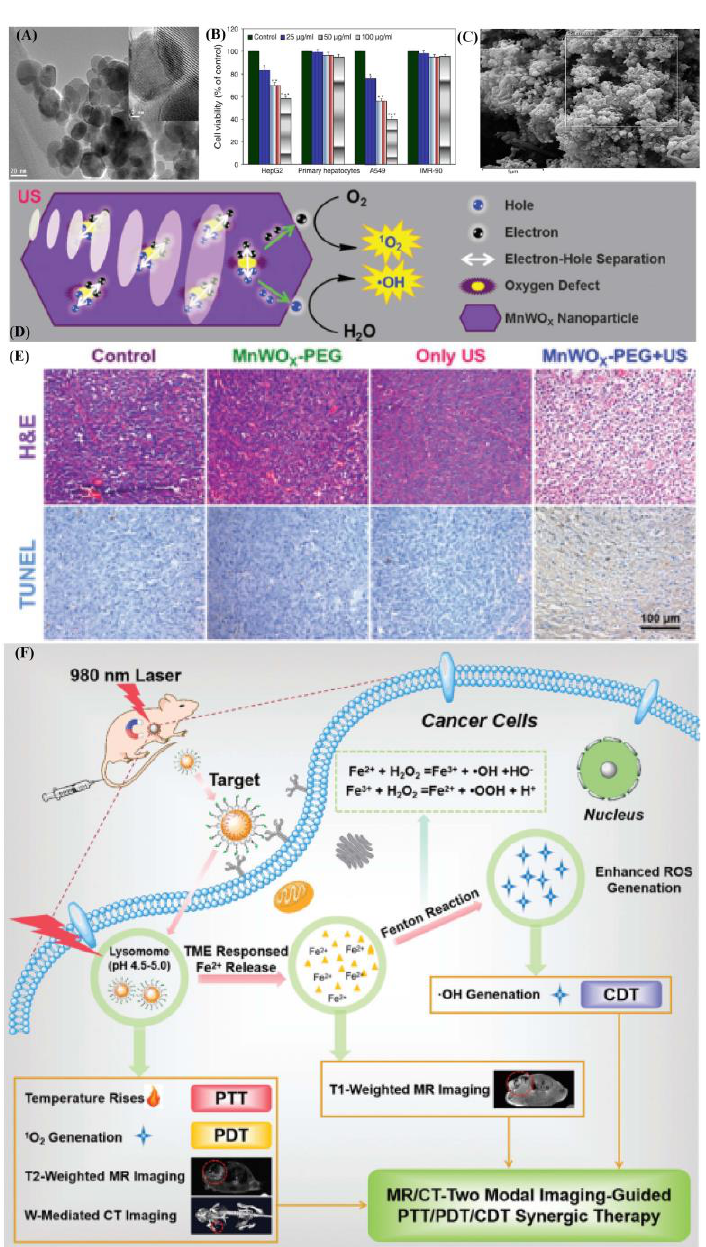
Figure 4. Metal-based magnetic composites as functional hard template in fabricating typical materials. ( A , B ) Structural information of pure phased Fe 3 O 4 and biocompatibility were tested in normal and cancer cell lines. Effect of Fe 3 O 4 on the viability of cancer cells and two types of normal cells; ( C ) FE-SEM image structural information of Fe 3 O 4 @C core-shell particles; ( D , E ) The proposed mechanism of ROS generation by MnWO X -PEG under ultrasound irradiation. Microscopy images of H&E and TUNEL-stained tumor slices; ( F ) Illustration of the fabrication of FeWOx–PEG–RGD NPs for (T 2 /T 1 -weighted) MR/CT dual-modal imaging-guided PTT/PDT/CDT synergistic therapy. These are reprinted with per-